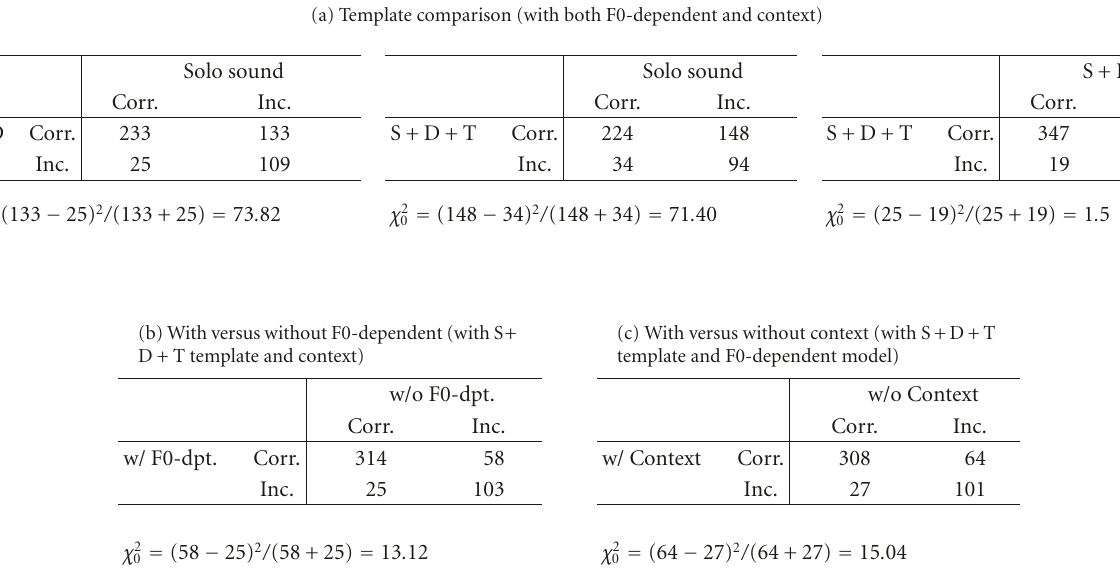
Table 7: Results of McNemar’s test for quartet music (Corr. = correct, Inc. =